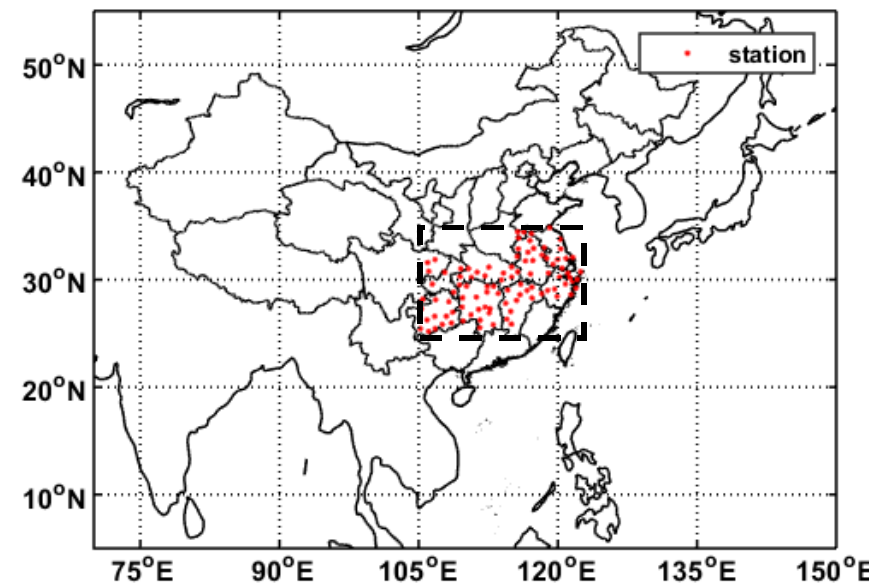
Figure 1. Location of the 97 meteorological stations over the MLYRB.